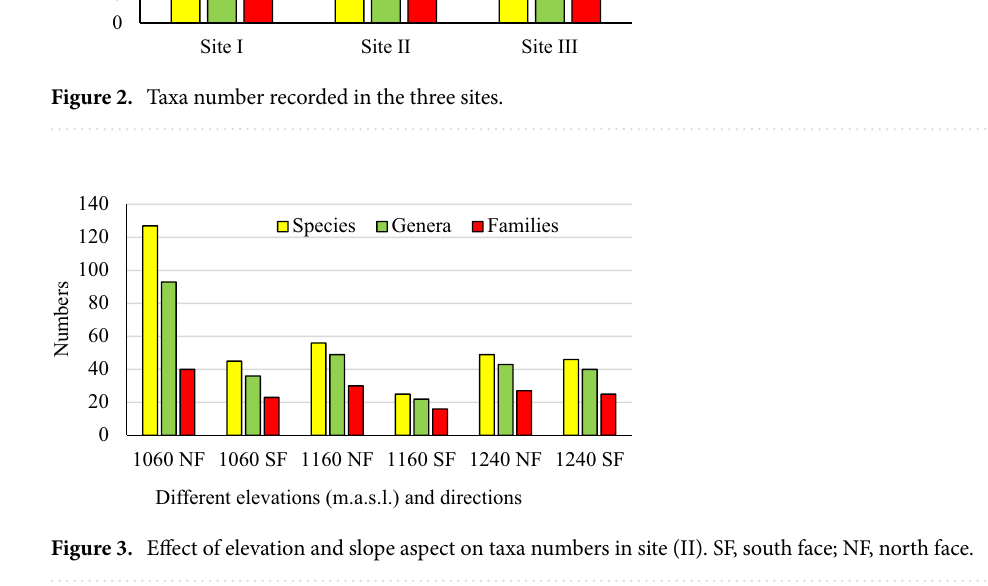
Figure 3. Effect of elevation and slope aspect on taxa numbers in site (II). SF, south face; NF, north